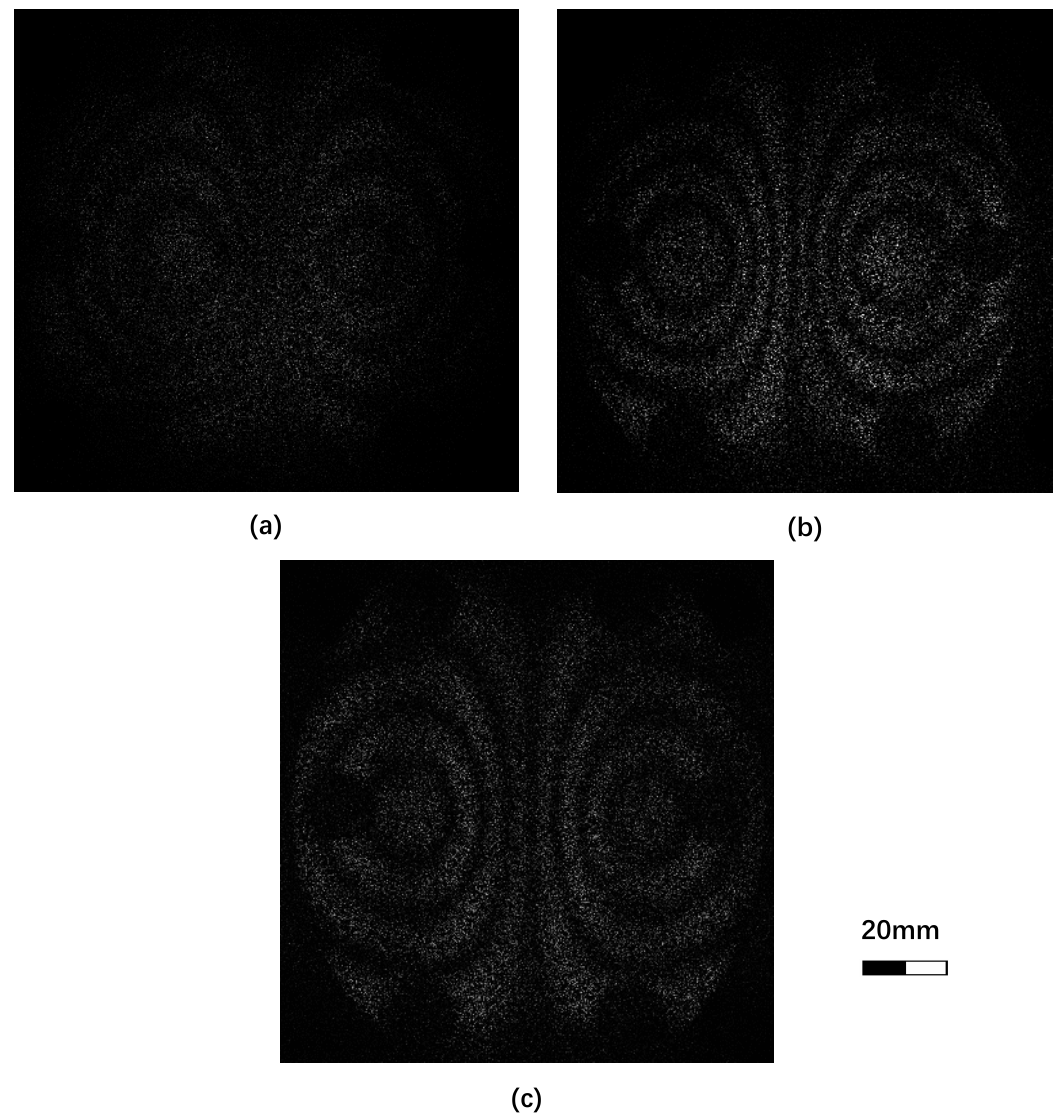
Figure 4. Fringe pattern under different shearing distance: ( a ) ∆𝑥 = 10 mm, ( b ) ∆𝑥 = 20 mm, and ( c ) ∆𝑥 = 30 mm .